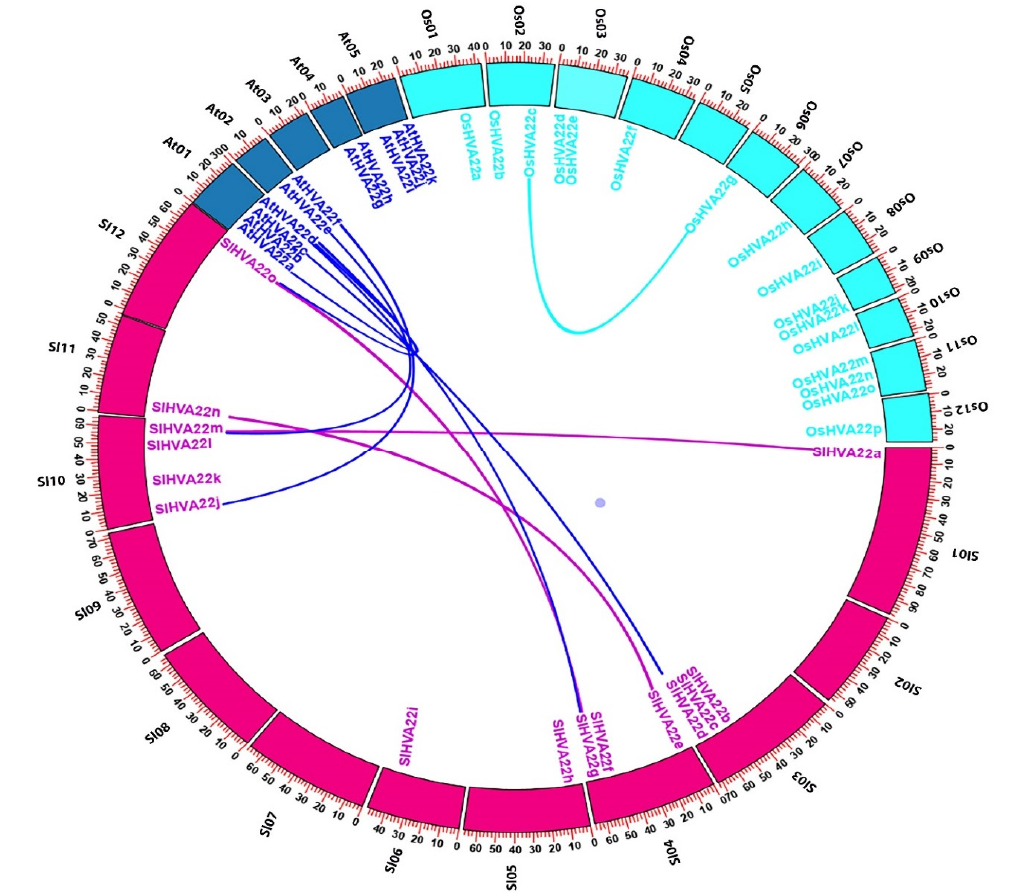
Figure 4. Microsyntenic relationship of HVA22 genes across Arabidopsis, tomato, and rice. The chromosomes of the three species are depicted by different colors: Arabidopsis, blue; tomato, pink-red; and rice, aqua. All chromosomes are illustrated with the scale in megabase pairs (Mbp). The duplicated SlHVA22 genes in tomato genomes are linked by pink-red lines.